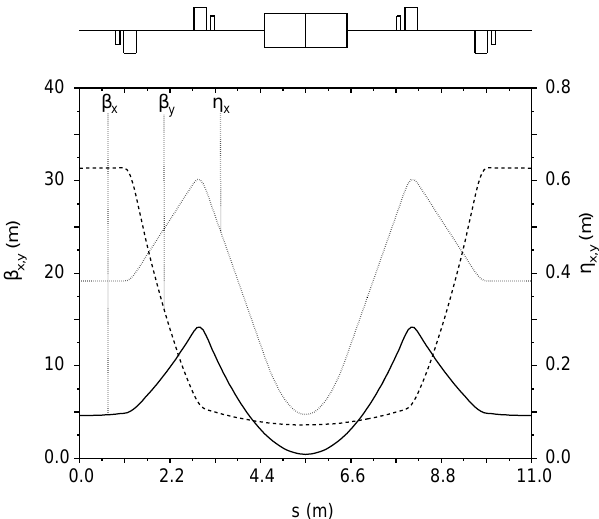
FIG. 7. Optical functions of a four-quad TME cell for the NLC